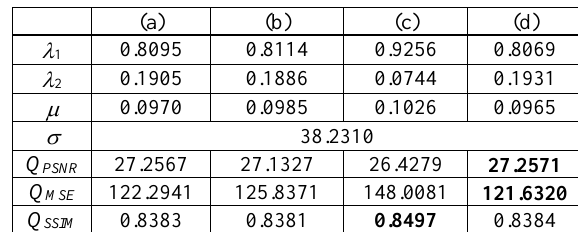
Figure 1. Denoising of real image: a) original image, b) cropped image, c) with Gaussian noise, d) with Poisson noise, e) with mixed noise, f) after denoising.